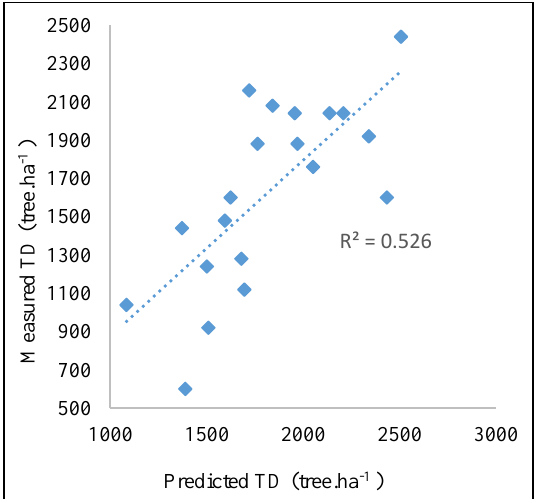
Fig. 3. The predicted values versus measured values for Linear Kernel (SVR